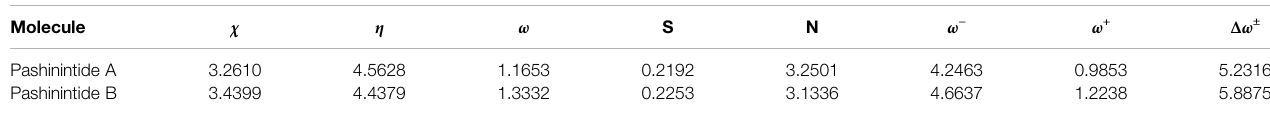
TABLE 10 | Global reactivity descriptors (in eV) for the Pashinintides A and B. Molecule χ η ω S